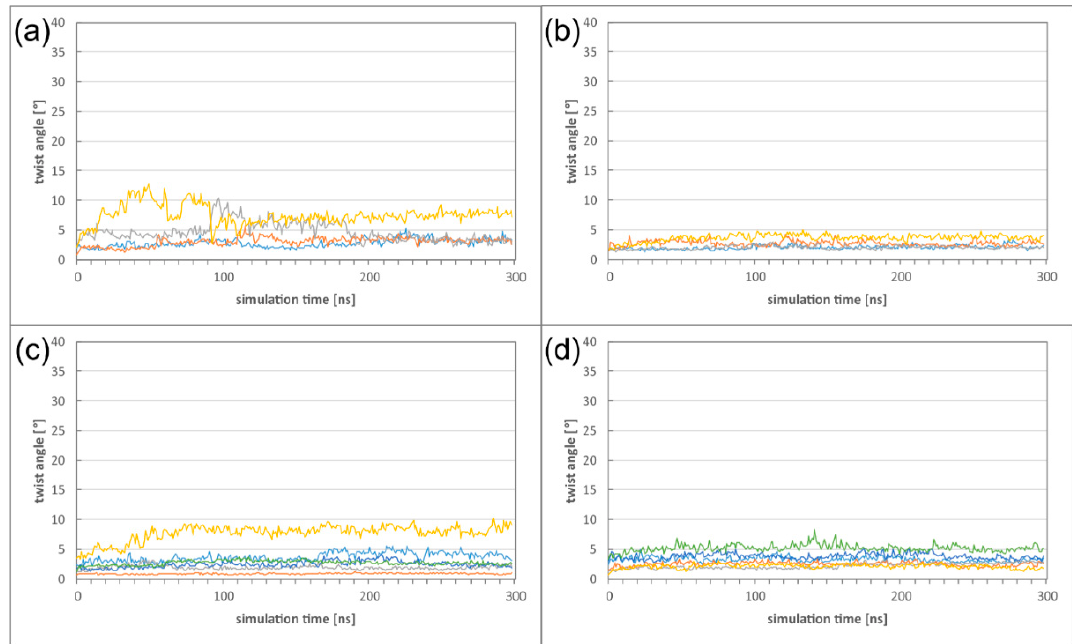
Figure 7. ( a ) Twist angle of the HCMV DimerDimer simulations; the two dimers of simulation run 1 are displayed in blue and orange, the two dimers of simulation run 2 are displayed in grey and yellow. ( b ) Twist angle of the HSV-1 DimerDimer simulations; the two dimers of simulation run 1 are displayed in blue and orange, the two dimers of simulation run 2 are displayed in grey and yellow. ( c ) Twist angle of the HCMV Hexagon simulations (run 1); the different colours mark the individual heterodimers. ( d ) Twist angle of the HSV-1 Hexagon simulations (run 1); the different colours mark the individual heterodimers.